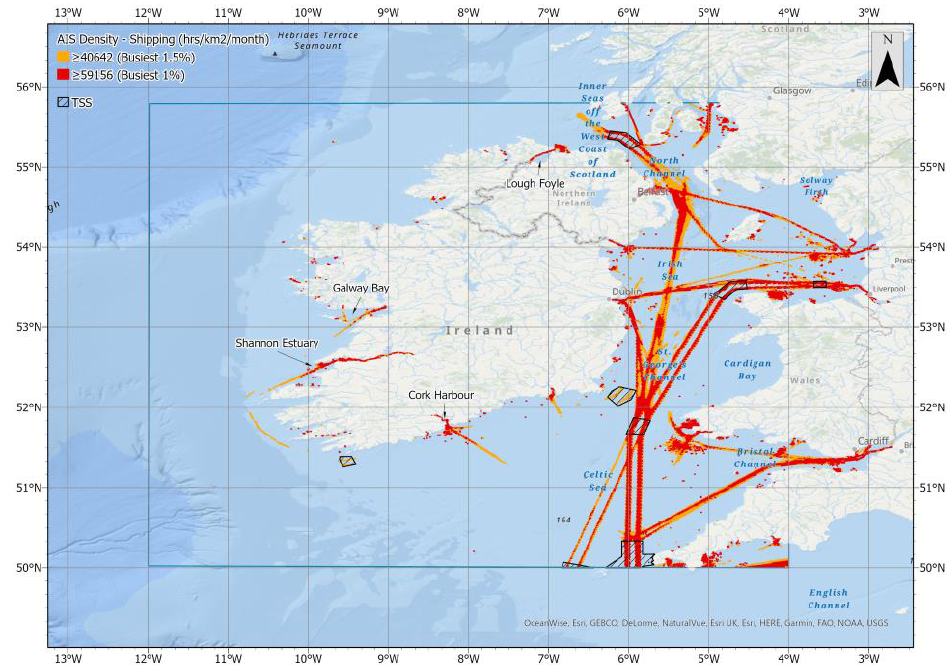
Figure 18. The busiest 1.5% (orange) and 1% (red) areas for shipping in the Selkie study area based on a three-year time series of AIS data (h/km 2 /month).